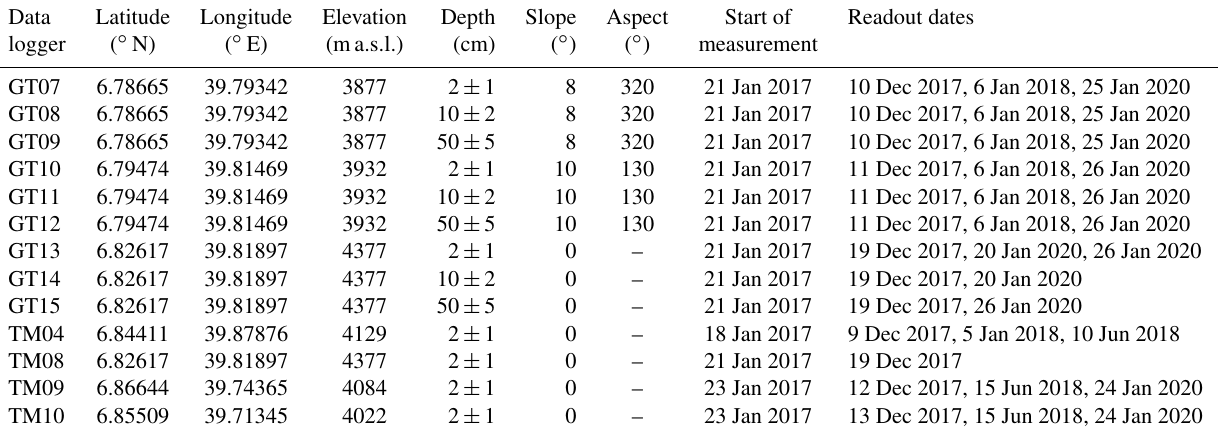
Table D1. Overview of the ground temperature data loggers installed on the Sanetti Plateau.